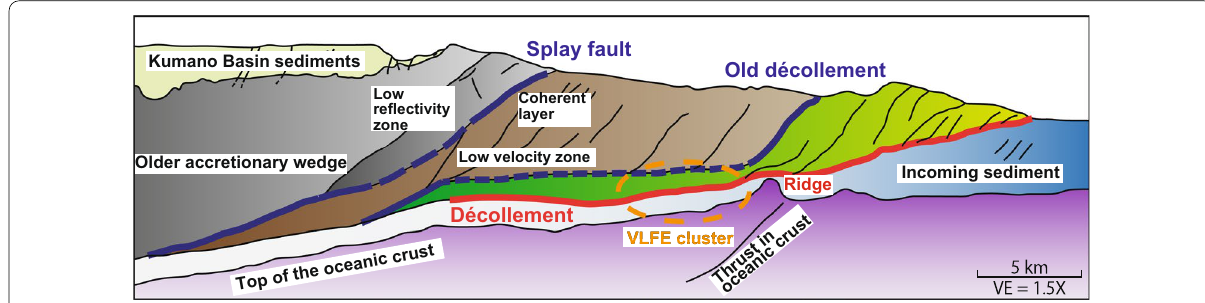
Fig. 6 Interpretation of the seismic section extracted from 3-D seismic data along the Nankai Trough–Kumano transect from Moore et al. (2009). Colored units (gray, brown, green, and blue) represent each interpreted BTH collisional unit. The location of a very-low-frequency earthquake (VLFE) cluster is marked according to Shiraishi et al. (2020). The original locations of the VLFEs were determined by Nakano et al.